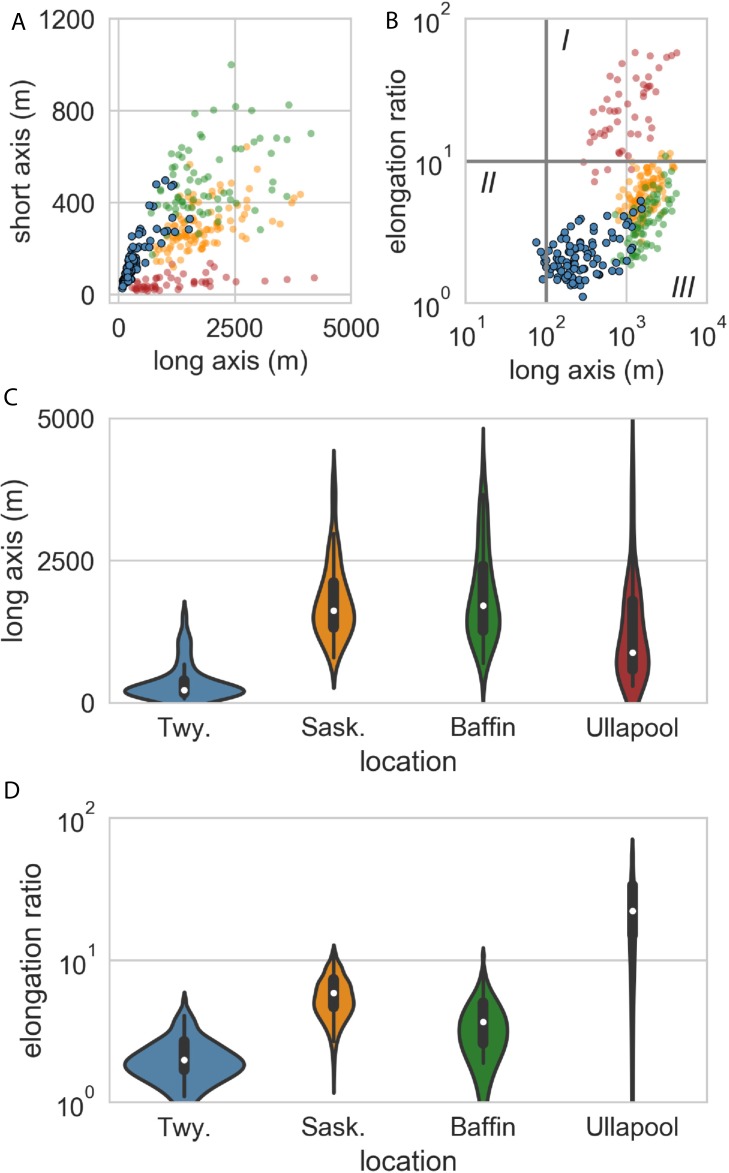
Geomorphometric data.(A) Cross-plot of MSGLs axes from Twyfelfontein (blue), Cree Lake, Saskatchewan (orange), Amadjuak Lake, Baffin Island (green), and Ullapool, Scotland (red). (B) Cross-plot of long axis length and elongation ratio. Fields for (I) megaridges, (II) rock drumlins and whalebacks, and (III) megawhalebacks follow Krabbendam et al. [18]. (C) Violin plot of the distribution of megalineation long axes between Twyfelfontein and the three comparison sites. The white dot is the median value, the heavy black line is the interquartile range, and the ‘violin’ is a mirror-imaged kernel density plot. (D) Violin plot of the distribution of megalineation elongation ratios for Twyfelfontein and the three comparison sites.